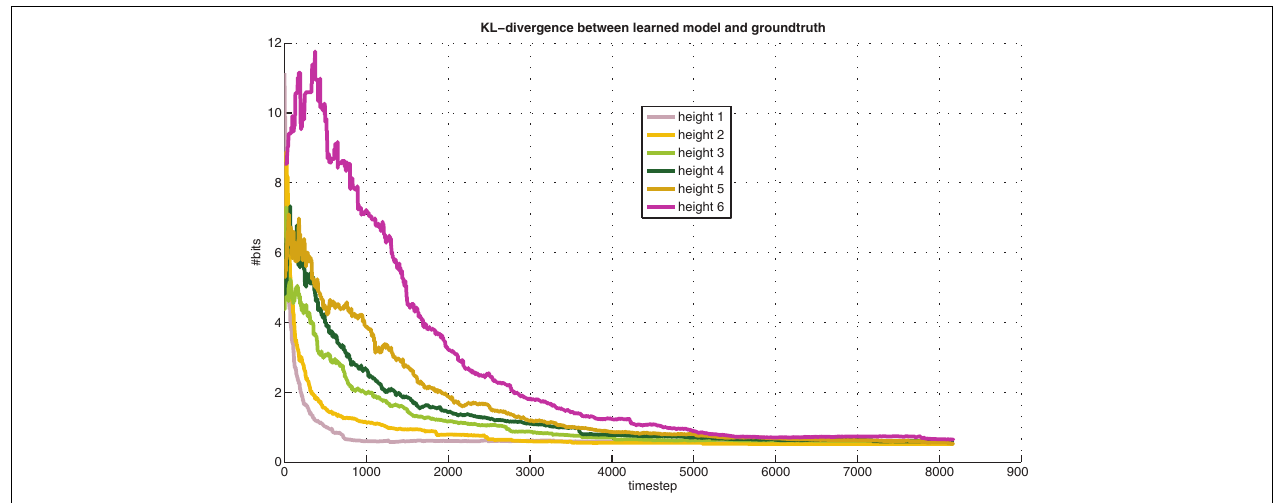
FIGURE 5 | KL-divergence between learned models and ground-truth models (averaged over 10 runs). Best viewed in